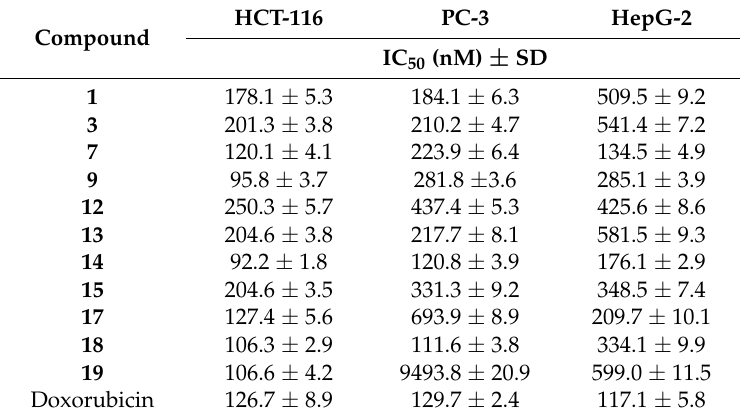
Table 1. The anticancer IC 50 values of compounds using a MTT assay against HepG-2, PC-3 and HCT116 cell lines.